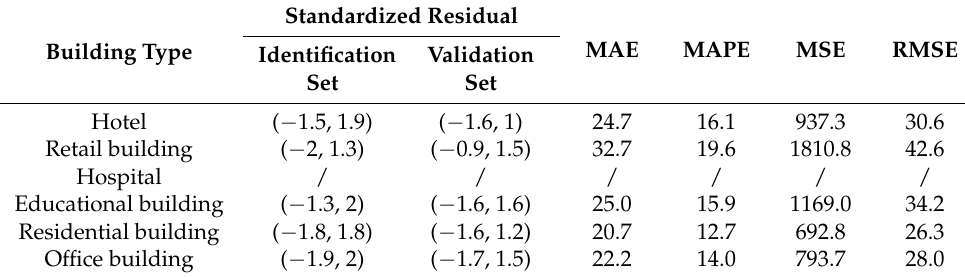
Table 9. Validation results of urban morphology sub-model.